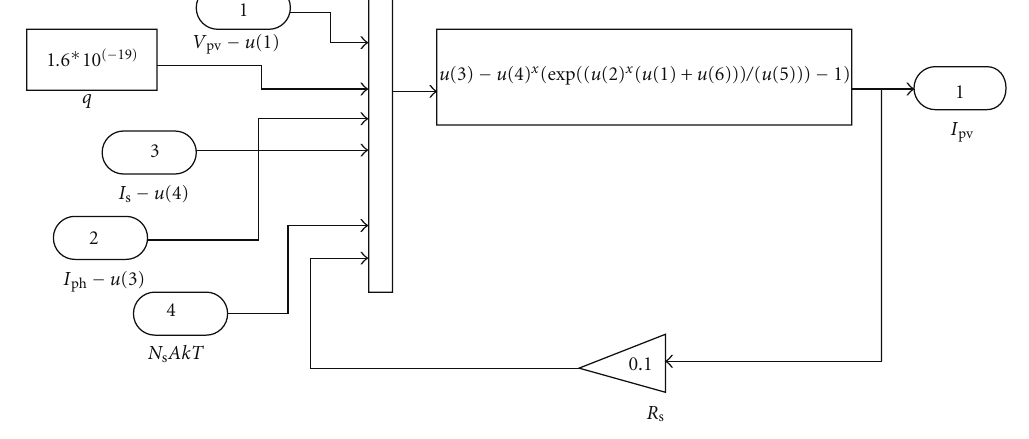
Figure 5: Module output current I pv . .